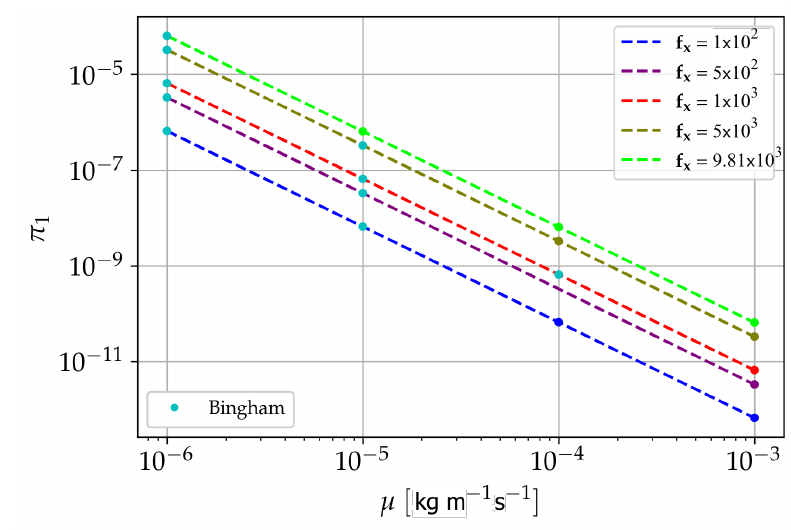
Figure 28. Dimensionless constant π 1 vs. µ at (cid:101) CS = 1 e − 14 for different values of f x .